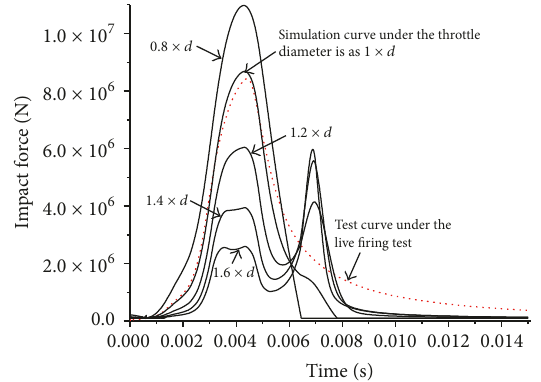
Figure9:Shockforcecurveofthehigh-powerhydraulicshockwave simulator under varying throttle diameter 𝑑 .